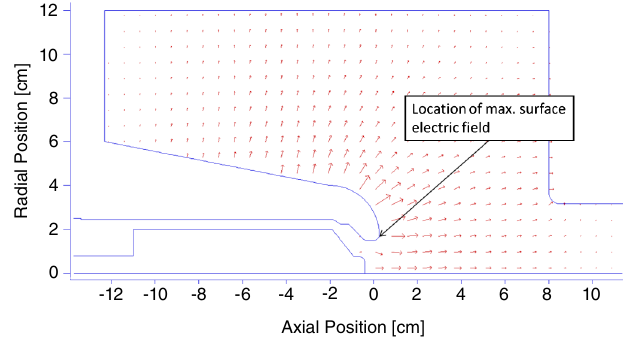
FIG. 14. Location of peak surface electric field in the cavity. With the cathode recessed 6.5 mm inside the nose cone, an on- cathode gradient of 6 : 5 MV = m at a phase of 90 degrees corre- sponds to a field on the tip of the nose cone of approximately 17 : 4 MV = m .